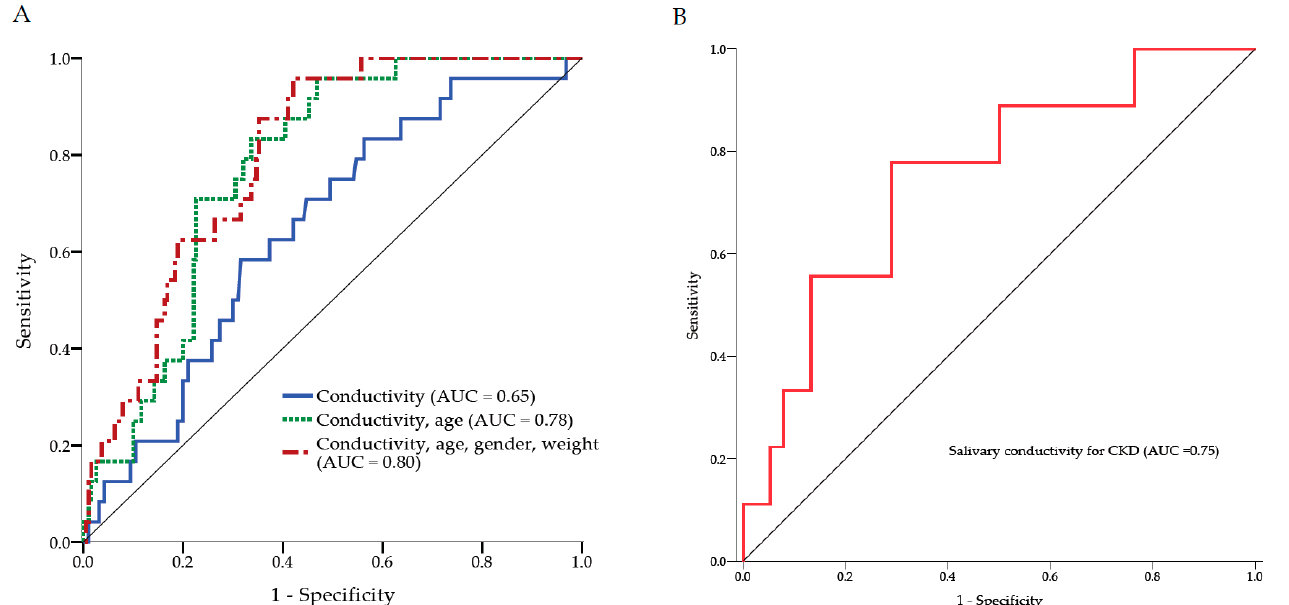
Figure 6. The receiver operating characteristic curve analysis. ( A ) Three ROC models for the diagnosis of CKD. The AUC was equal to 0.65 when salivary conductivity is the only predicting factor. The combination of salivary conductivity, age, gender, and body weight as the predicting factors showed the AUC was increased to 0.80. ( B ) The ROC curve analysis for the diagnostic accuracy of salivary conductivity on CKD among subjects older than 75 years. AUC, area under the ROC curve; CKD, chronic kidney disease; ROC, receiver operating characteristic.